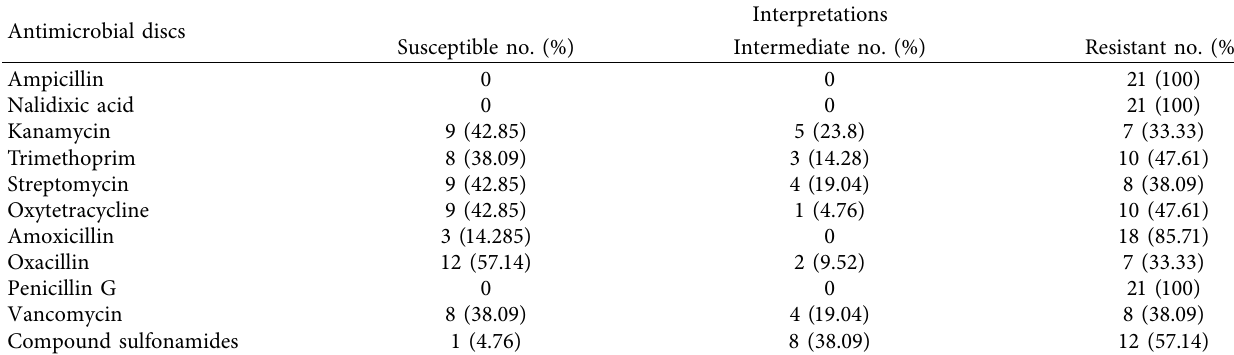
Table 1: In vitro antimicrobial drug susceptibility test results of S. aureus isolates. Antimicrobial